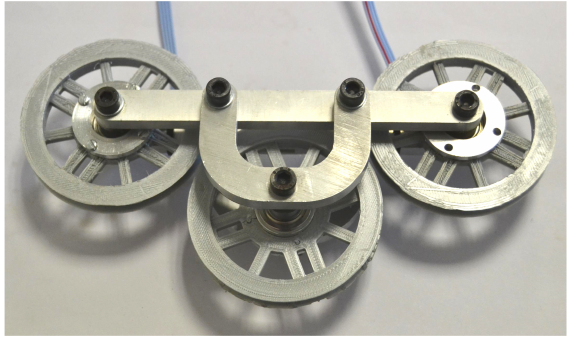
Figure 9. Prototype for